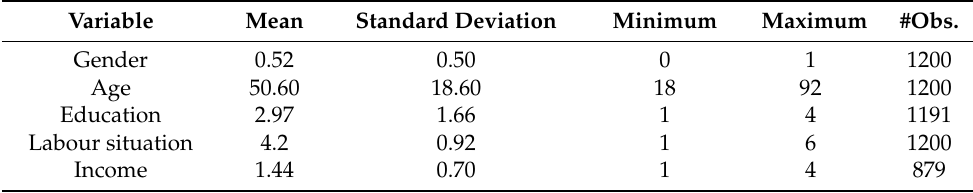
Table 3. Statistical summary of the demographic